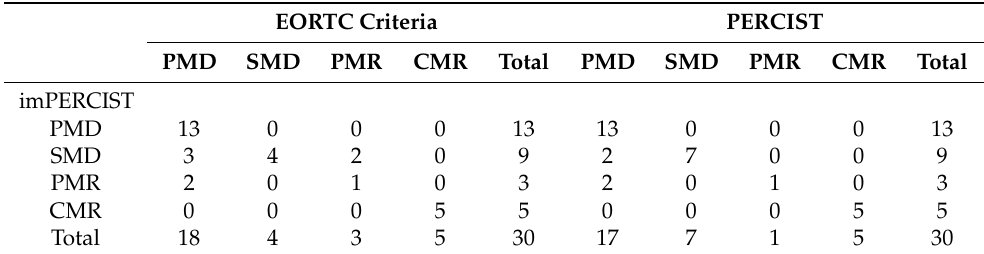
Table 3. Comparison of treatment response assessments in imPERCIST and two other PET citeria (EORTC criteria and PERCIST).